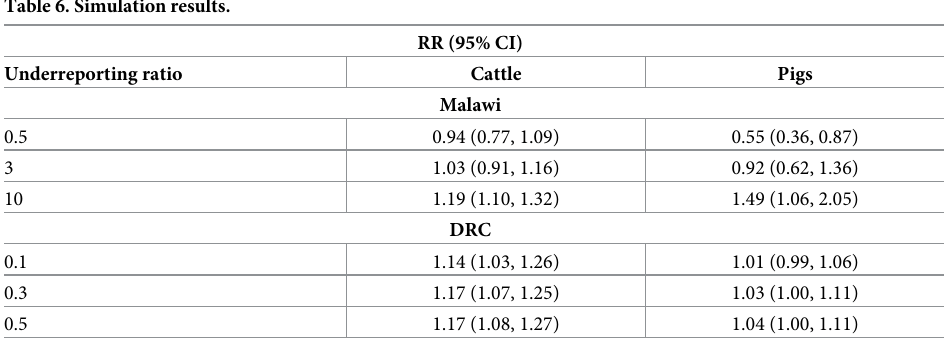
Table 6. Simulation results.